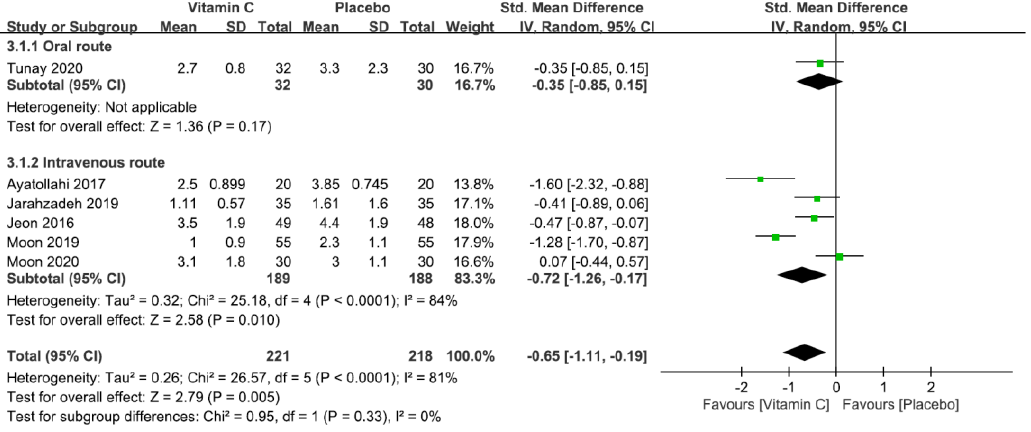
Figure 6. Forest plot for comparing the severity of pain at 24 h after surgery between vitamin and placebo groups. CI, confidence interval; IV, inverse variance; Std., standardized.